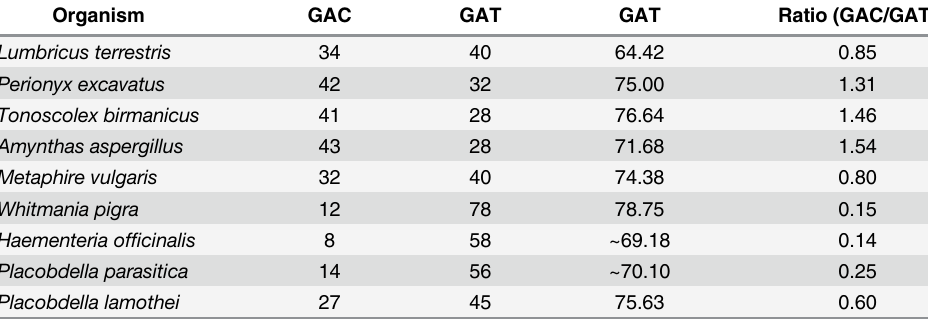
Table 1. Codon usage for aspartic acid in Clitellata mitochondrial genomes. Number of codons present in proteins used to code aspartic acid in Clitellata mitochondrial genomes. Even though all Hirudinea, except for P . lamothei , have a strong bias for the use of the GAT codon, they exclusively code for the trnD gene with a GUC anticodon. Organism GAC GAT GAT Ratio (GAC/GAT) Lumbricus terrestris 34